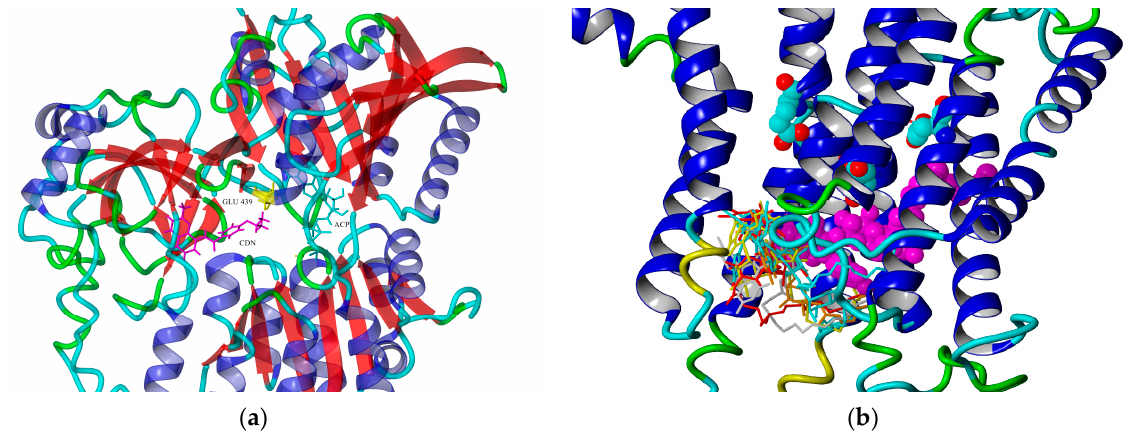
Figure 6. Binding site of CDN1163 in 4xou model of SERCA1a as calculated by YASARA software. CDN1163—magenta, Glu439—yellow and ACP—cyan ( a ); binding modes of rutin derivatives (stick models) in 3w5c model of SERCA1a ( b ). Rutin arachidonate (magenta) shows the position form MD simulation [56]. Glu309, Glu771, and Glu908 are depicted in ball model, element colors. Table 2. Score values of rutin derivatives compared with their inhibition activities to SERCA.